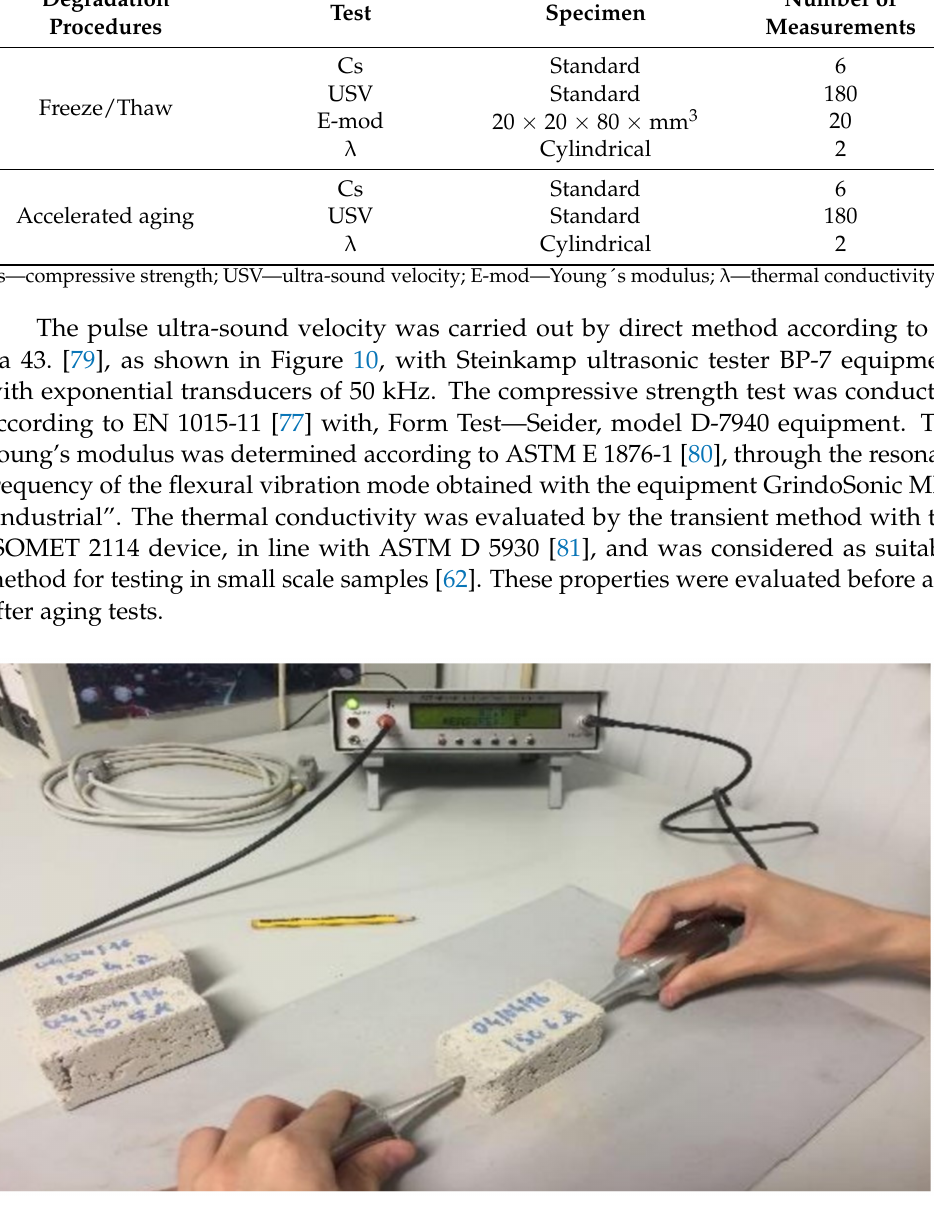
Figure 10. Ultra-sound velocity test